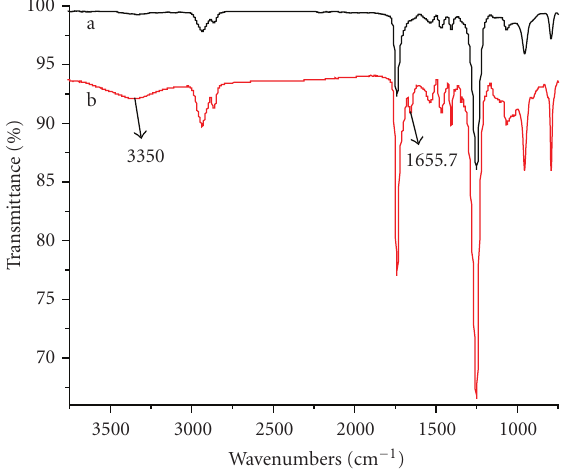
Figure 3: ATR-FTIR spectra of PU-NH 2 (a) and PU-HA films (b).